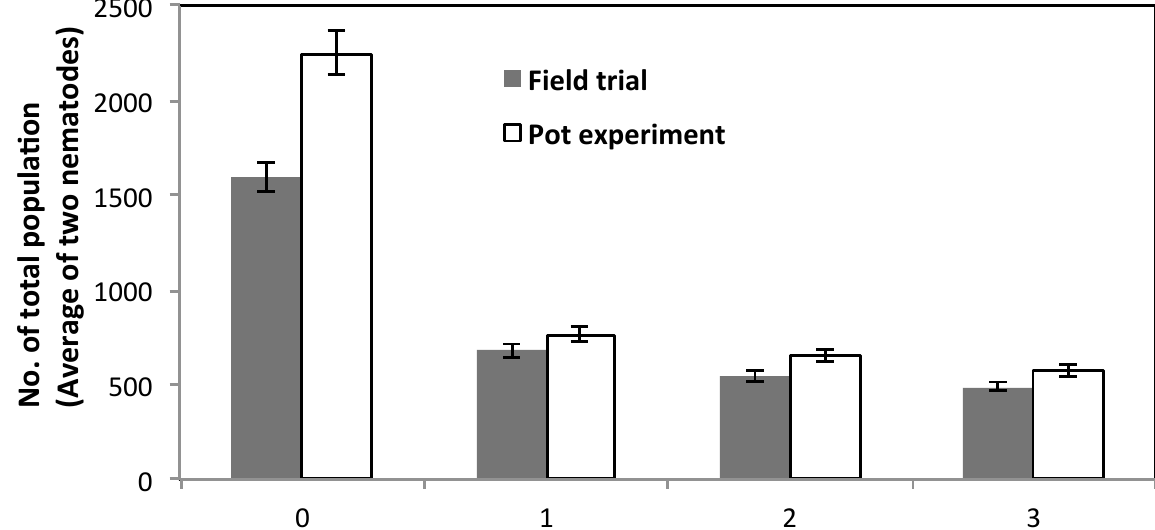
Figure 2. Mean total populations of Aphelenchoides besseyi and Ditylenchus angustus in pots and irrigated field trials. 0 = average number of nematodes each inoculated singly; 1 = 75:25; 2 = 50:50; 3 = 25:75 ( D. angustus : A. besseyi ). Vertical bars indicate standard